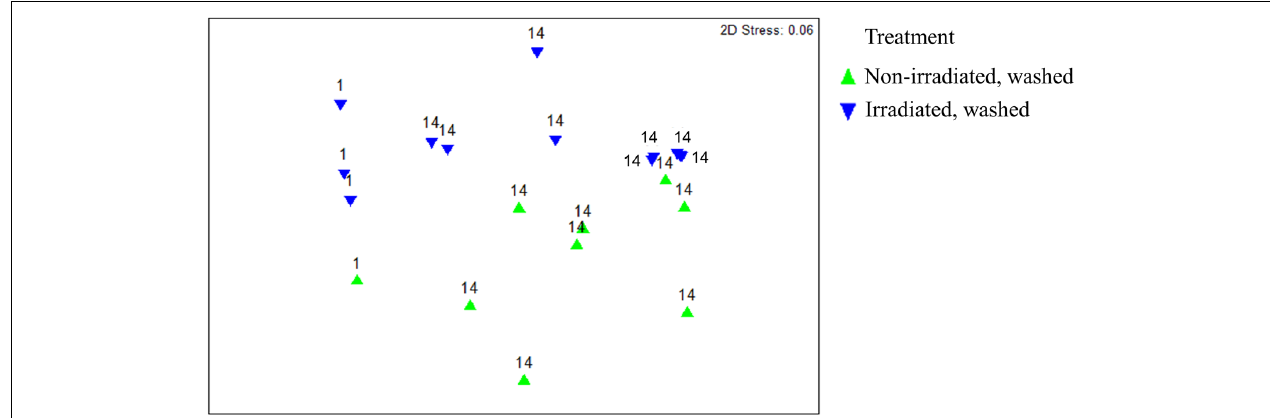
FIGURE 1 | Non-metric multidimensional scaling analysis of weighted Unifrac distance matrices of surficial bacterial microbiota found on irradiated and non-irradiated lettuce surfaces after 1 and 14 days of storage based on 16S rRNA gene amplicon sequencing. Each point represents one lettuce sample. ANOSIM, R = 0.171, p = 0.036 indicates irradiated and non-irradiated lettuce had overall similar bacterial community structures (ANOSIM, R > 0.25 and p < 0.05). ANOSIM, R = 0.673, p = 0.002 indicates distinct bacterial community structures on lettuce surfaces stored for 1 vs. 14d.